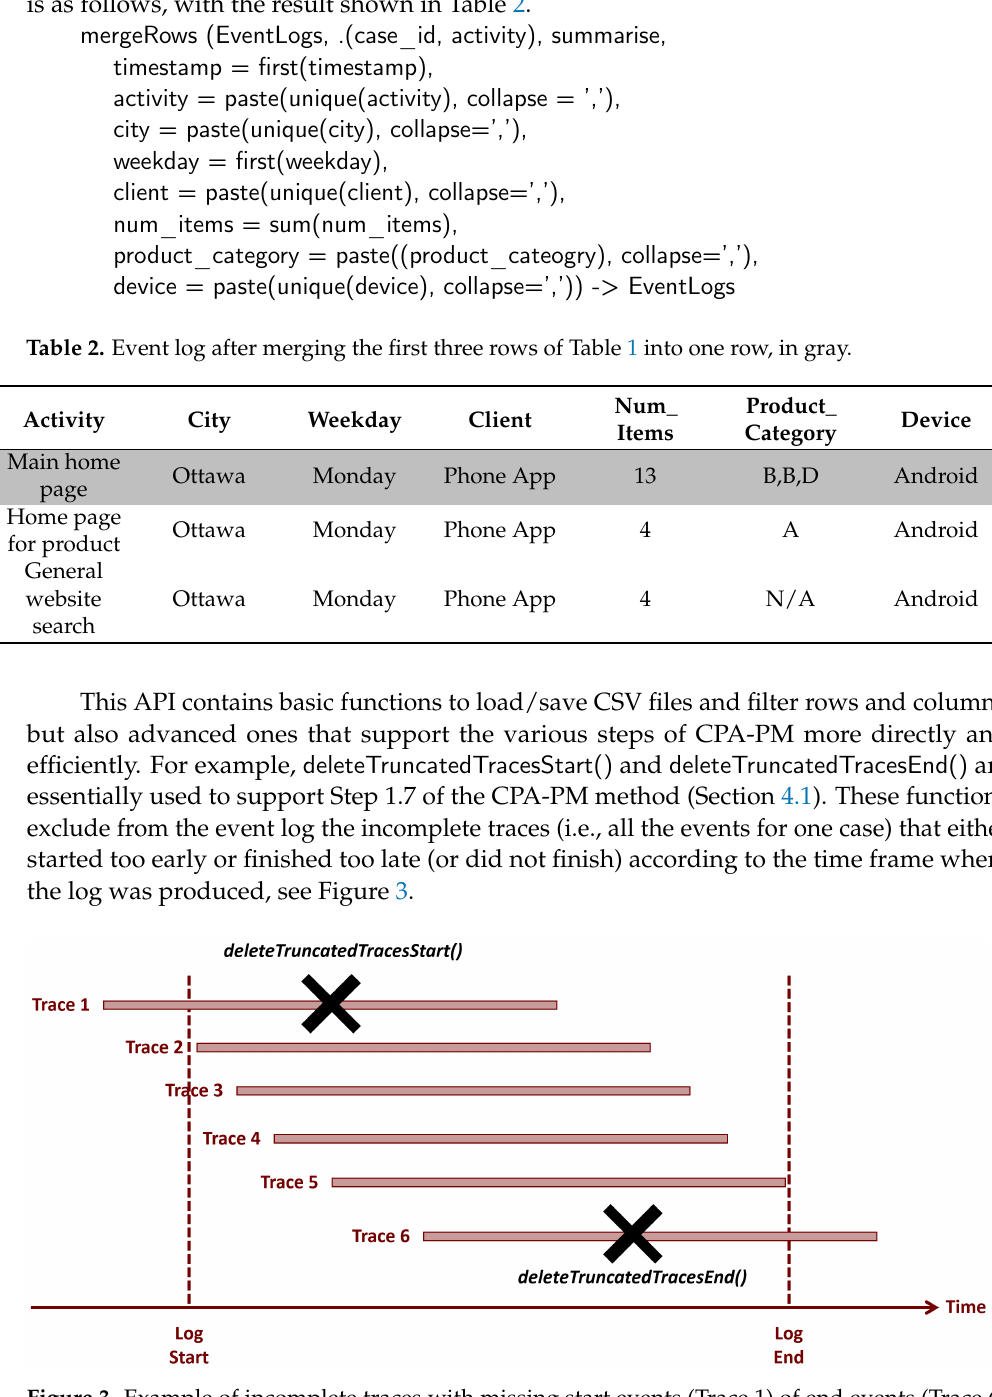
Figure 3. Example of incomplete traces with missing start events (Trace 1) of end events (Trace 6). The trace removed by each function is shown with an X